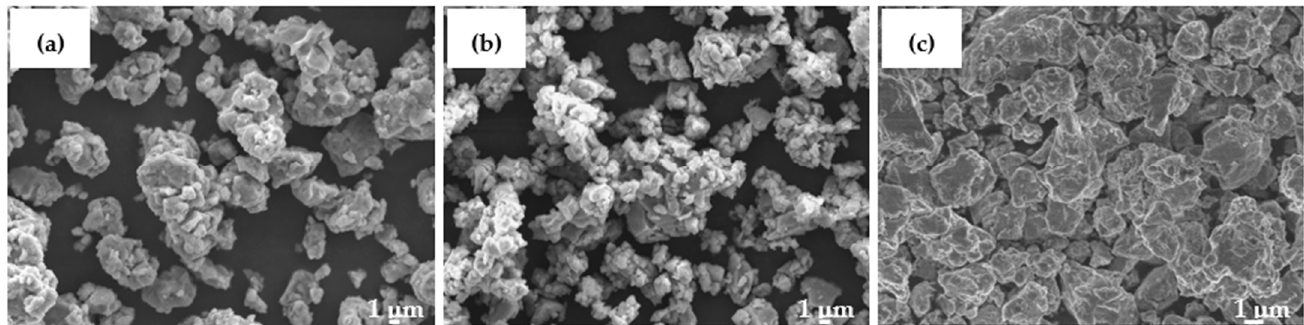
Figure 1. FE-SEM micrographs of ( a ) Al 82 Fe 16 Ti 2 , ( b ) Al 82 Fe 16 Ni 2 , and ( c ) Al 82 Fe 16 Cu 2 powders after 40, 50, and 60 h of milling, respectively.